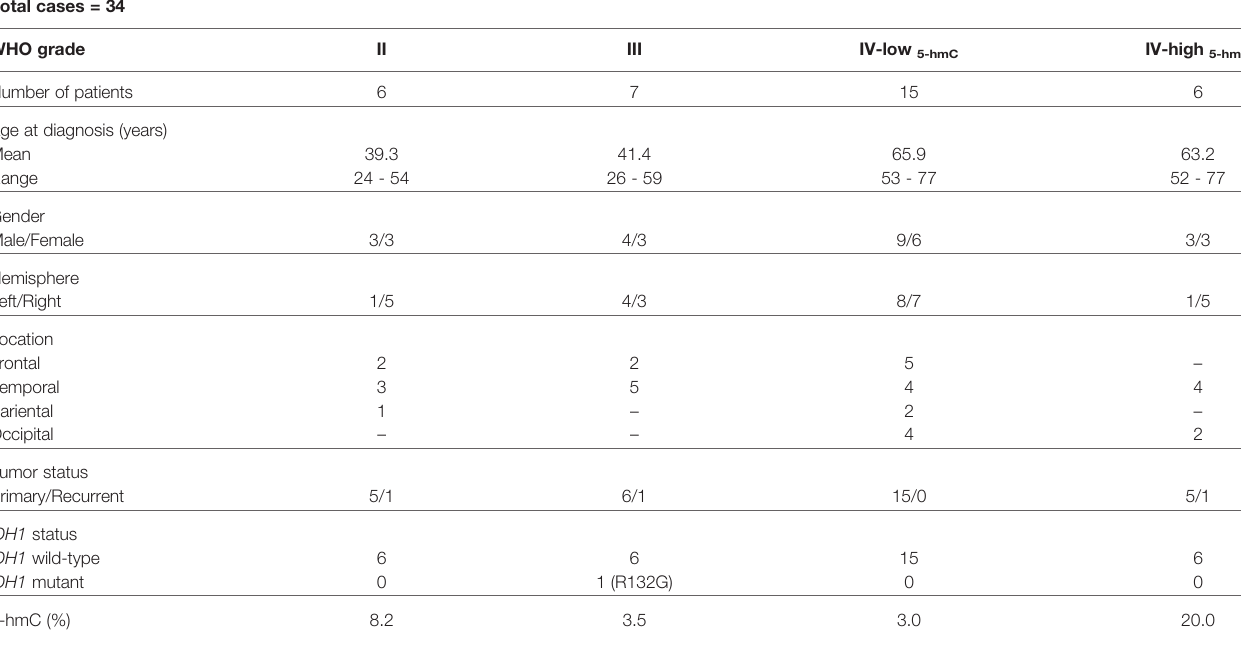
TABLE 1 | Characteristics of glioma